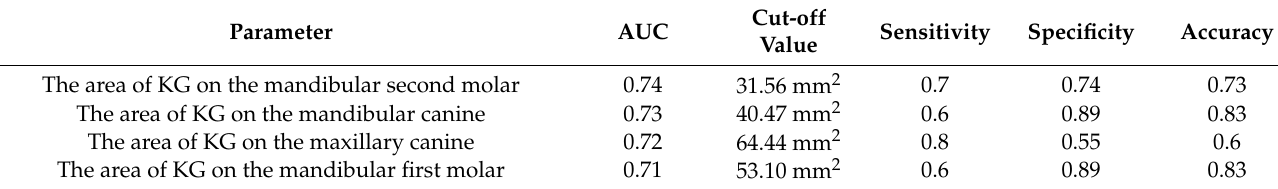
Table 4. Area under the receiver operation characteristics curve, sensitivity, specificity and accuracy of the selected teeth. Parameter AUC